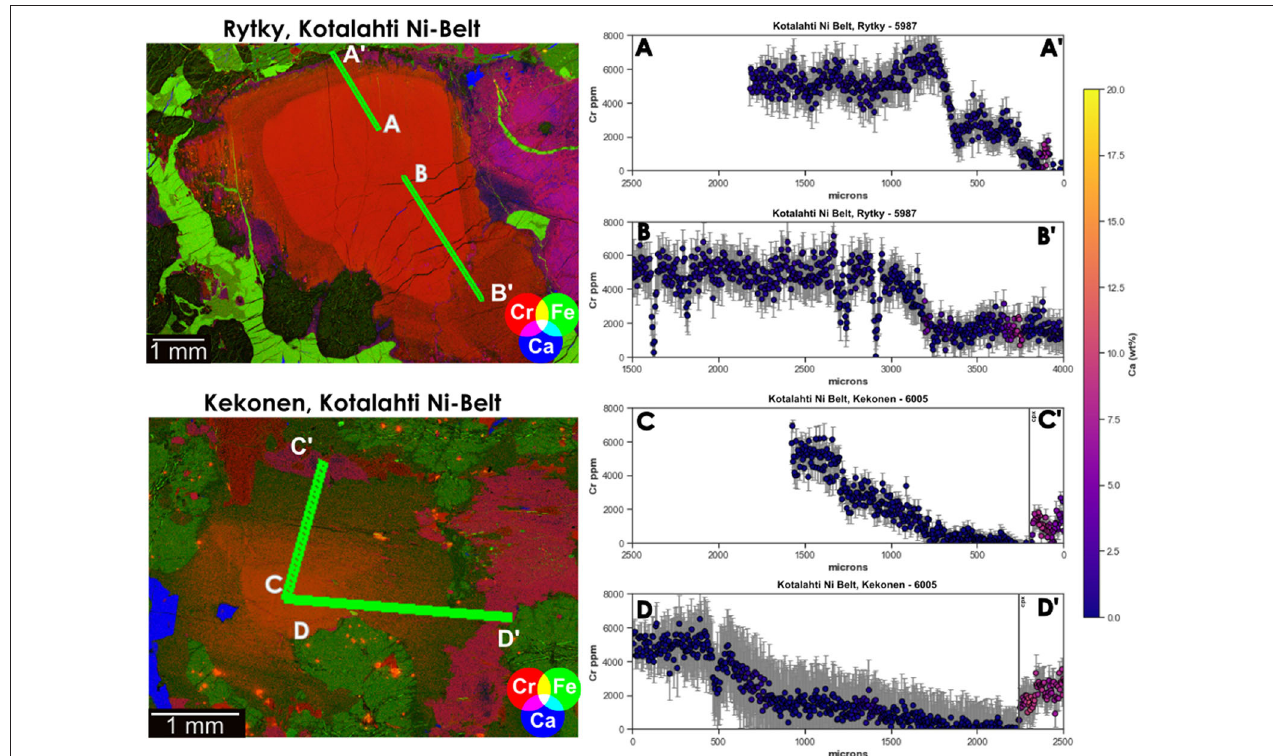
FIGURE 5 | Traverses through abrupt zonation in orthopyroxene (opx) grains. Traverse (A,B) are on an orthopyroxene from Rtyky while (C,D) are from the Kekonen intrusion. Both samples are from Kotalahti Ni-belt. The degree of abrupt zonation may depend on crystal orientation. The sector zoning in the second grain represents looking down the (C) axis. Therefore (C,D) are traverses approximately along with (A,B) axis. Each traverse is cropped to a total of 2,500 um and presented as core to rim traverses so we can directly compare between traverses. Color scheme is wt% Ca content of the analysis to ensure orthopyroxene composition with no